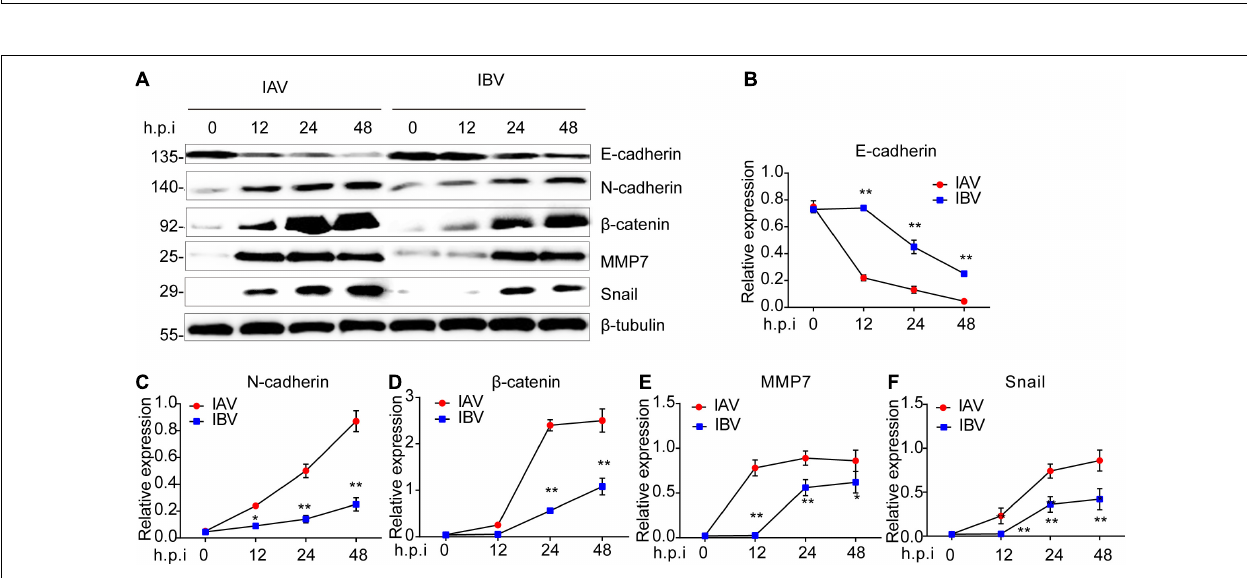
FIGURE 3 | Influenza A and B viruses enhance the mRNA expression levels of EMT-related genes in A549 cells. A549 cells were infected by IAV and IBV (MOI = 0.005) for 0, 6, 12, and 24 h and the expression of E-cadherin (A) , N-cadherin (B) , β -catenin (C) , vimentin (D) , snail (E) , cyclin D (F) , PPAR (G) , TCF-1 (H) , and TGF- β (I) was detected by qPCR. Data are representative of three independent experiments ( n = 3). Data are presented as the mean ± SD. * p < 0.05 and ** p < 0.01 (unpaired, two-tailed Student’s t -test).